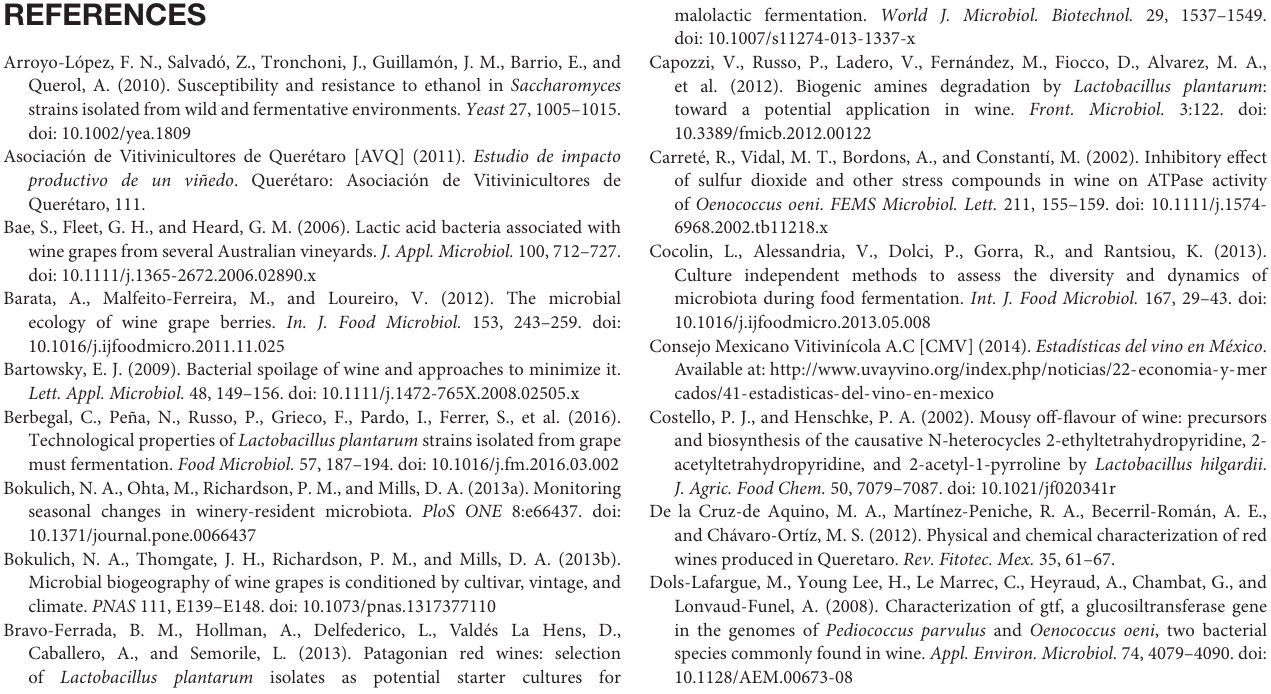
FIGURE S1 | Proportion of LAB species recovered in three media from must, wine and barrel/filter rinse: MRS, Man Rogosa Sharpe; MRS-T, MRS added to tomato juice; and MRS-AJ, MRS added to apple